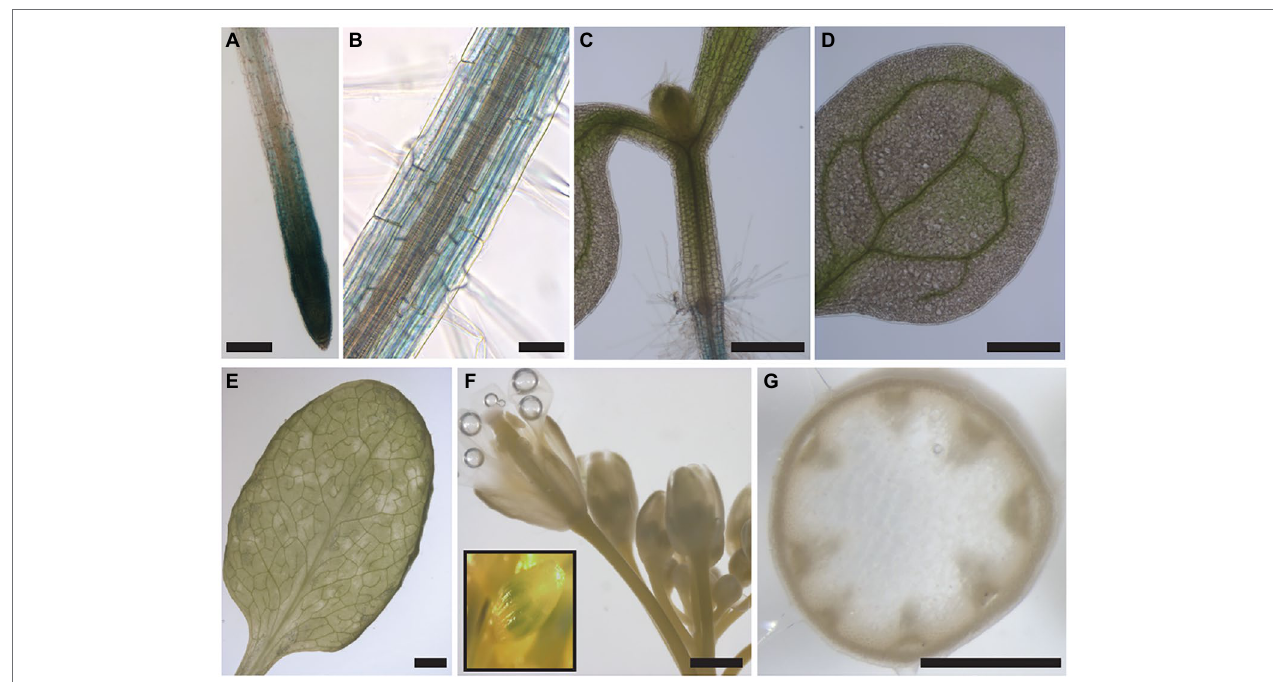
FIGURE 5 | ABCB11 is primarily expressed in the root and root tip. (A) Strong proABCB11:GUS expression is observed in the root tip. Roots were stained for 1 h. (B) Moderate proABCB11:GUS expression is observed in the epidermis, cortex, and endodermis of the mature root. (C–G) proABCB11:GUS expression is not observed in the (C) hypocotyl, shoot apex, or petioles, (D) cotyledons, (E) rosette leaves, (F) apical regions of the inflorescence stem or mature flowers, or (G) upper 3–4 cm of the inflorescence stem. Occasional staining could be observed in young unopened flowers ( E , inset). Stems in (G) were GUS stained prior to hand sectioning. Scale bars: (A,F,G) 500 μ m, (B,F) 1 mm, (C,E) 2 mm, (D) 100 μ